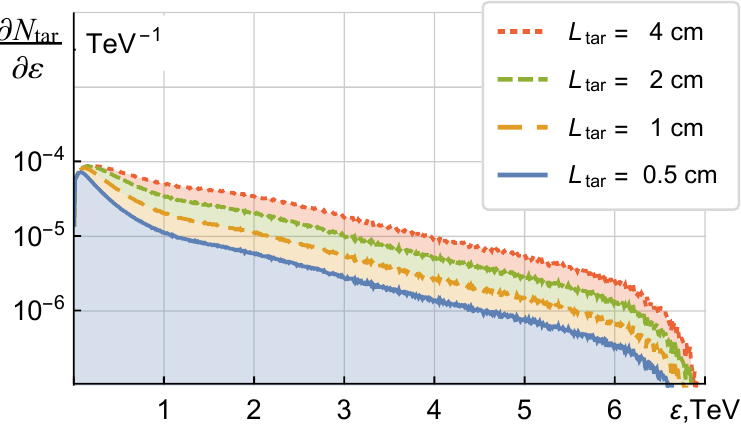
Figure 4 . Spectra of (cid:3) + baryons right after the tungsten targets of di(cid:11)erent thicknesses L tar (listed c on the